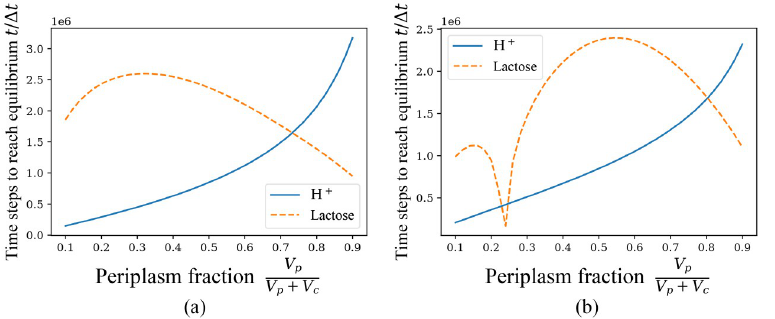
Fig 8. Time to reach equilibrium with the variation of periplasm fraction V p , ξ = 1. Different time for H + and V p þ V c lactose to reach equilbrium state with the unit of Δ t . The sum of volumes of periplasm and cytoplasm is fixed, V + V = c p 2 × 10 6 / C 0 . (a) Initial particle concentration fixed, and the initial conditions are like n ¼ 10 3 ; n ¼ 0 ; 1 k 6¼ 1 = V ¼ C = 10 ; N H þ = V ¼ C = 1000 ; N L = V ¼ C = 40 ; N L = V ¼ 3 C = 40 . (b) Initial particle population fixed, and N H þ 0 0 0 0 p c p c p c p c ¼ 10 3 ; n ¼ 0 ; N H þ ¼ 10 5 ; N L ¼ 2 : 5 � 10 4 ; N L ¼ 7 : 5 � 10 4 ; N H þ ¼ 10 3 the initial conditions are like n 1 k 6¼ 1 p c p c